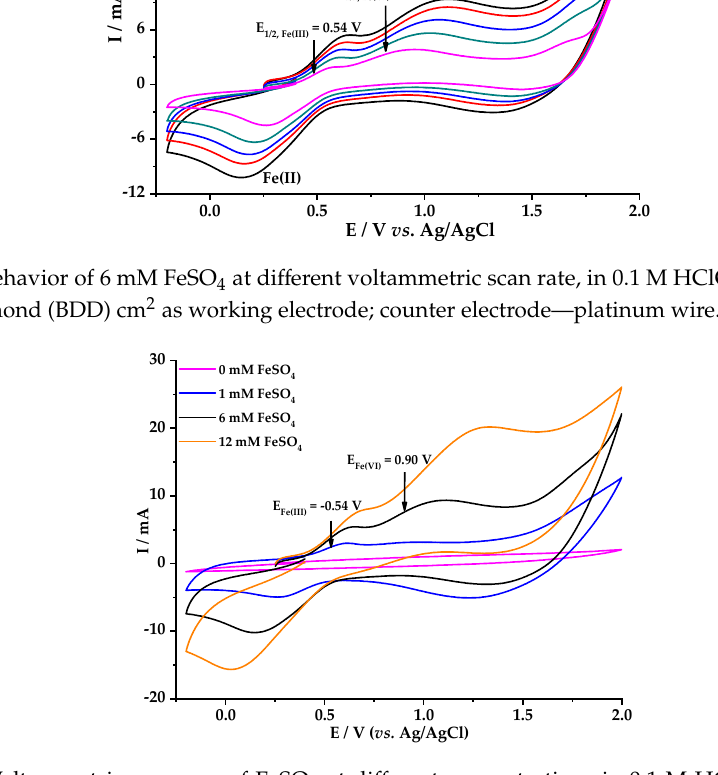
Figure 2. Voltammetric response of FeSO 4 at di ff erent concentrations in 0.1 M HClO 4 , with BDD 0.5 cm 2 as working electrode, scanning speed 50 mV s − 1 ; counter electrode—platinum wire.